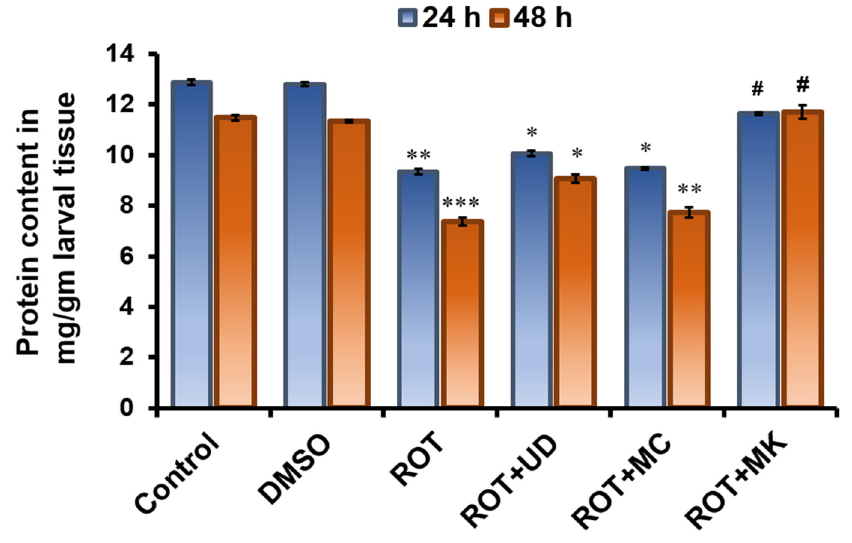
Figure 7. Total protein content in third instar larvae of D. melanogaster (Oregon R + ) exposed to 500 µ M rotenone for 24 and 48 h. Data represent the mean ± SD of three identical experiments made in three replicates. Significance is ascribed as * p < 0.05, ** p < 0.01, *** p < 0.001 vs. control or DMSO control. # = significance at * p < 0.05 as compared with 500 µM rotenone. UD= Urtica dioica , MC = Matricaria chamomilla and MK= Murraya koenigii .